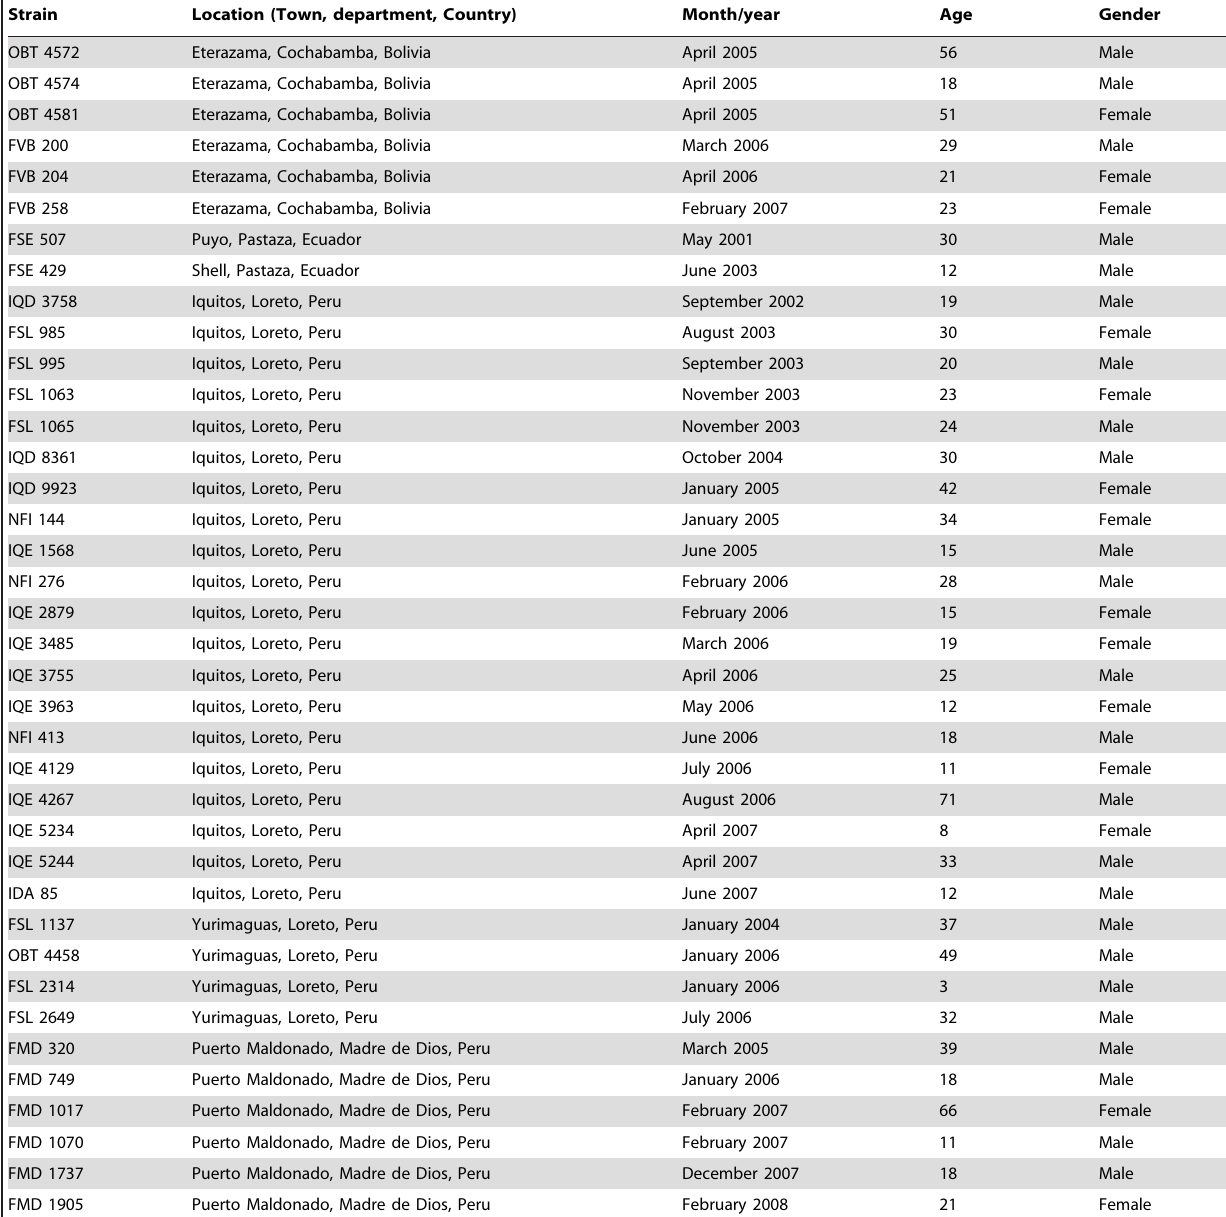
Strain Location (Town, department,